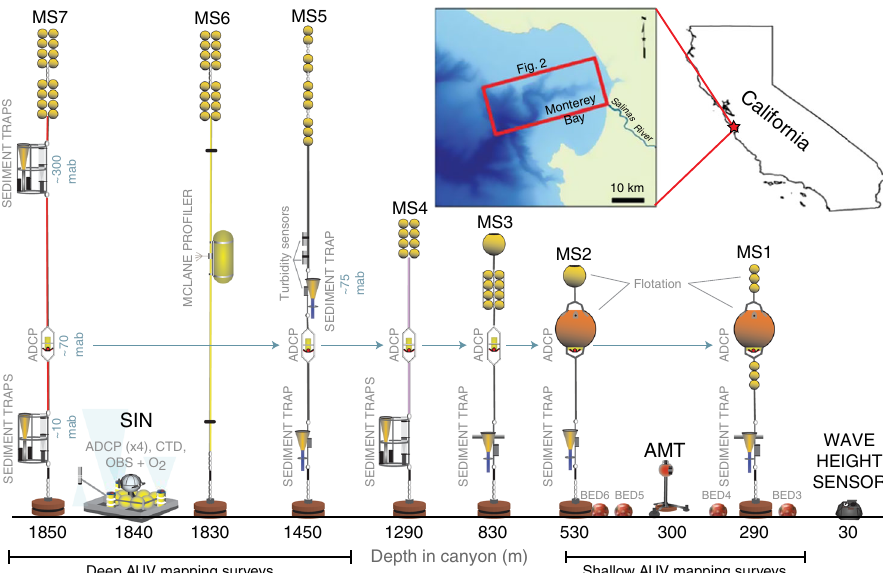
Fig. 1 Instrument array. Schematic drawing (not to scale) showing monitoring instruments deployed within Monterey Canyon. Inset maps show location of Monterey Canyon with respect to California and area covered by map in Fig. 2. Moored ADCPs were positioned 65 to 70 m above bottom